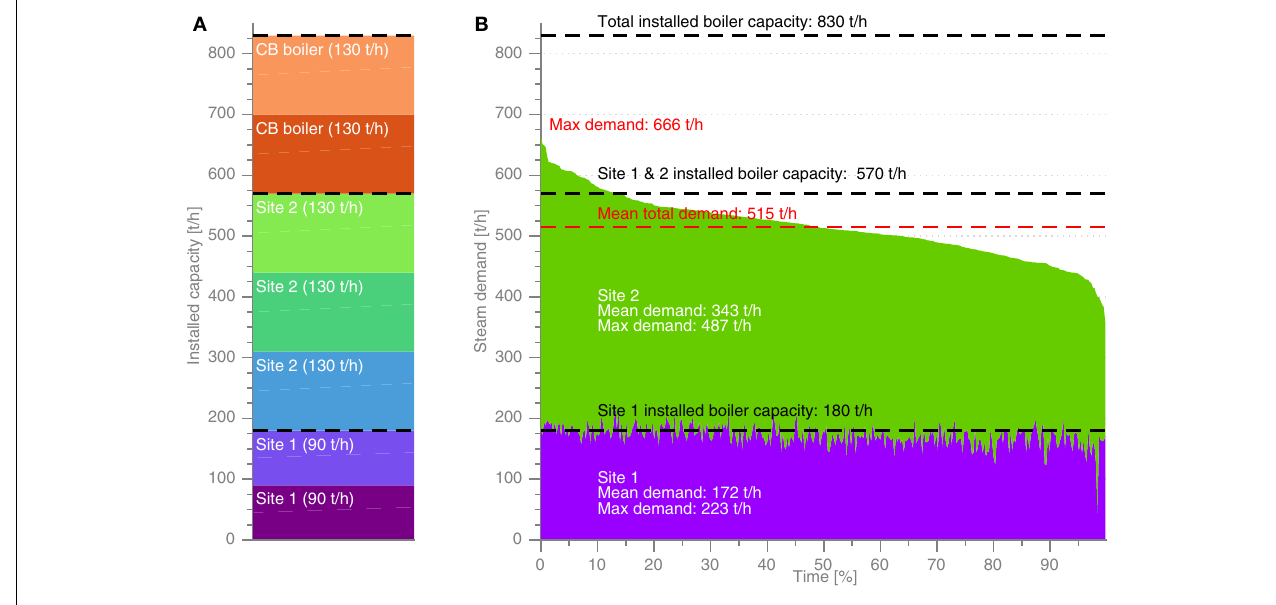
FIGURE 5 | Cluster installed capacity (A) and load duration curve (B) .